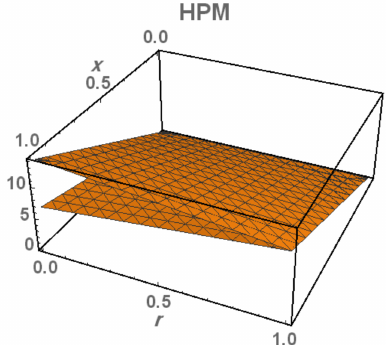
Figure 10. Solution of the tenth-order double parametric fuzzy HPM at t = π , b = 0.2,0.8 for all x ∈ [ 0,1 ] and r ∈ [ 0,1 ] .